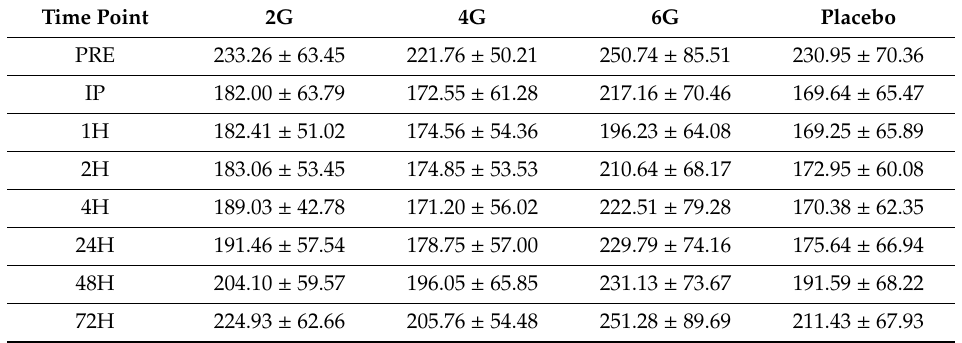
Table 3. Maximal voluntary isometric contraction of the dominant limb knee extensors for each group at all time-points. All values are newton-meters (Nm). n = 8 / group; 4 males and 4 females per group Time Point